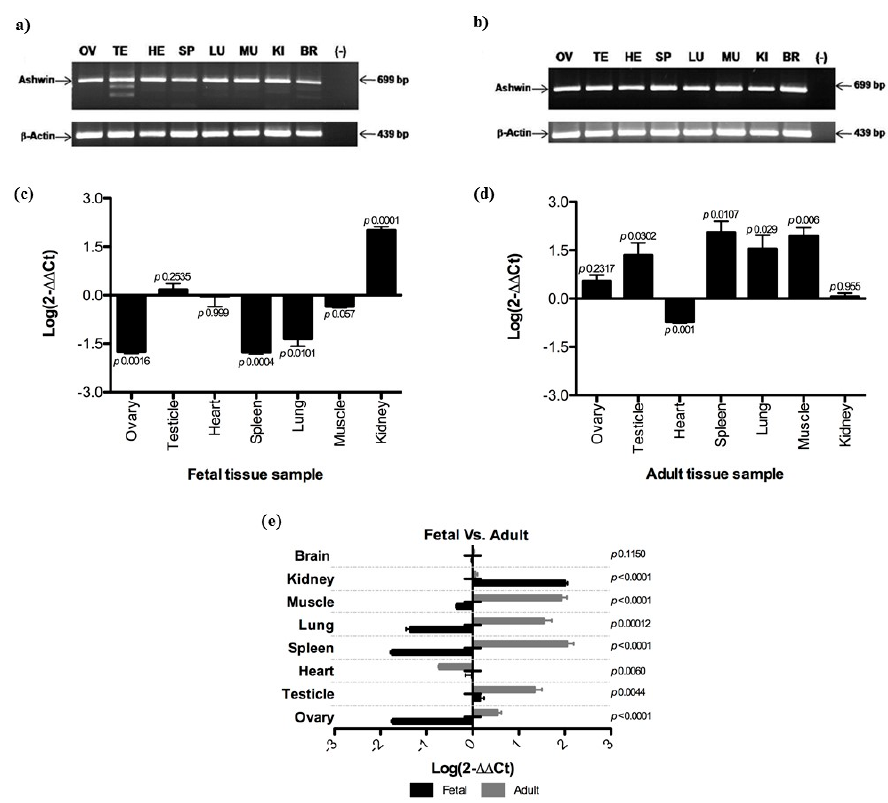
Figure 1. Ashwin expression profiles in fetal and adult tissues. ( a , b ) Agarose gel electrophoresis polymerase chain reaction (PCR) targeting genes encoding for ashwin and β -actin at the fetal and adult stages, respectively; ( c , d ) quantitative PCR results for ashwin gene expression in different tissues at the fetal and adult stages, respectively; ( e ) relative expression at the fetal and adult stages. Data were analyzed using a two-sample Student's t -test. Data are presented as means ± standard deviations from two independent quantitative real-time PCR experiments (average of three independent reverse transcription reactions, each tested with three PCRs). Dunnett multiple comparison tests were performed, and expression in fetal and adult brain tissues served as a reference. Ashwin expression levels were normalized using the 2- ∆∆ CT